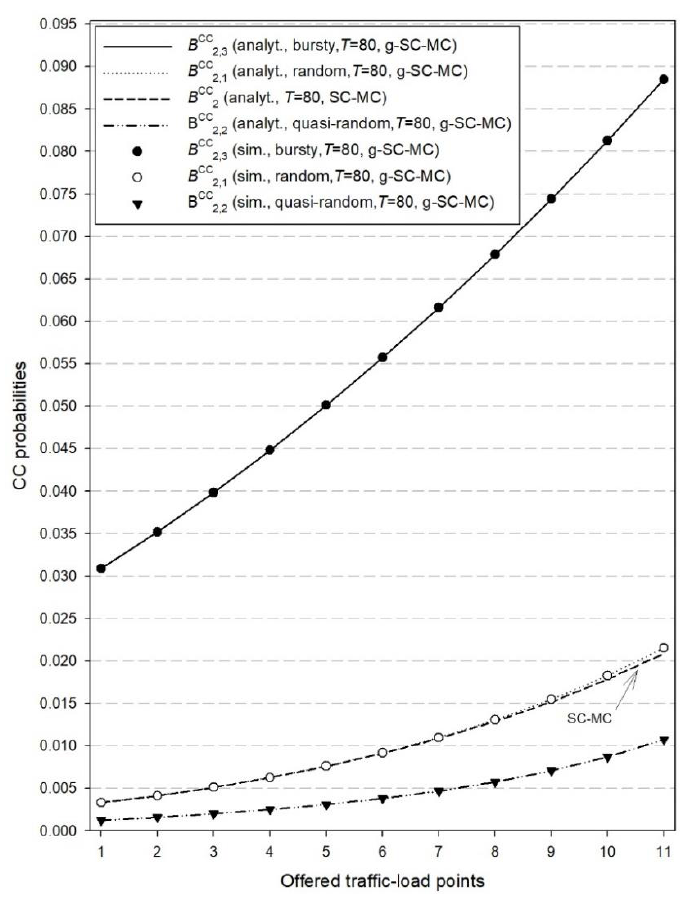
CC B ) for the second cluster and both models. Figure 7. CC probabilities ( B CC and B and B CC ) for the second cluster and both 2 ,m 2 2, m 2